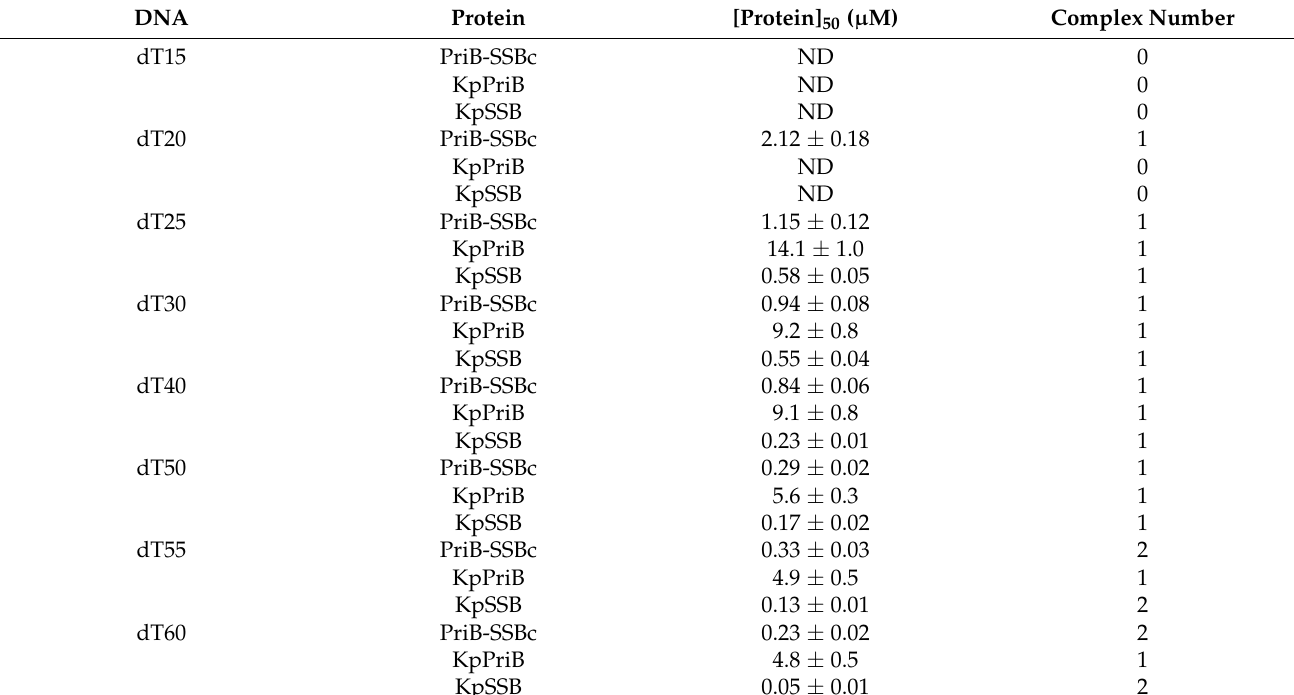
[Protein] 50 was calculated from the titration curves of EMSA by determining the concentration of the protein ( µ M) needed to achieve the midpoint value for input ssDNA binding. For some oligonucleotides, input ssDNA binding was the sum of the intensities from the two separate ssDNA-protein complexes. Errors are standard deviations determined by three independent titration